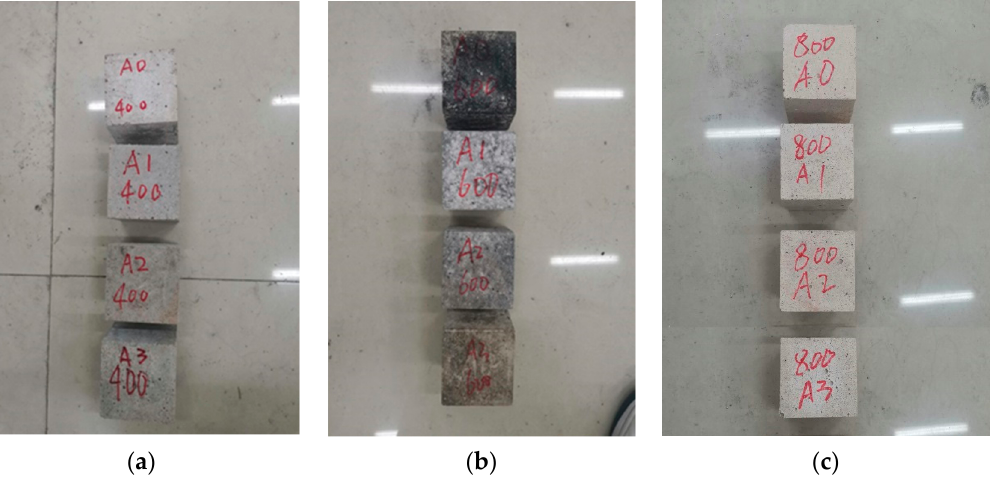
Figure 7. Experimental specimens after high ‐ temperature overheating: ( a ) 400 °C, ( b ) 600 °C, ( c ) 800